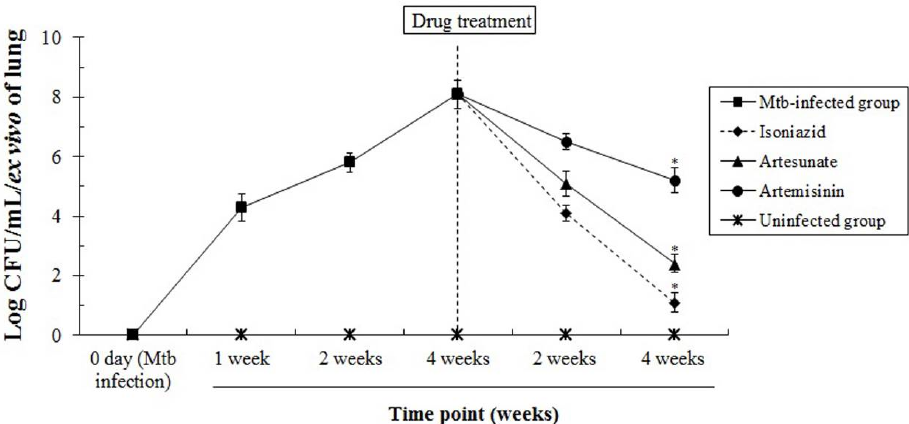
Figure 5. The in vivo tests of artesunate and artemisinin. The rats (six weeks/female) were divided into a normal group ( n = 5), positive control group ( n = 5/isoniazid group) and experimental groups (artesunate and artemisinin groups, n = 5/each group). The rats were orally administered with a single dose of 5 mg/kg of isoniazid, and 3.5 mg/kg of artesunate and artemisinin, once a day for four weeks, after four weeks of Mtb infection, respectively. The rats were carefully observed during the experimental periods. * p < 0.05 was considered to be statistically